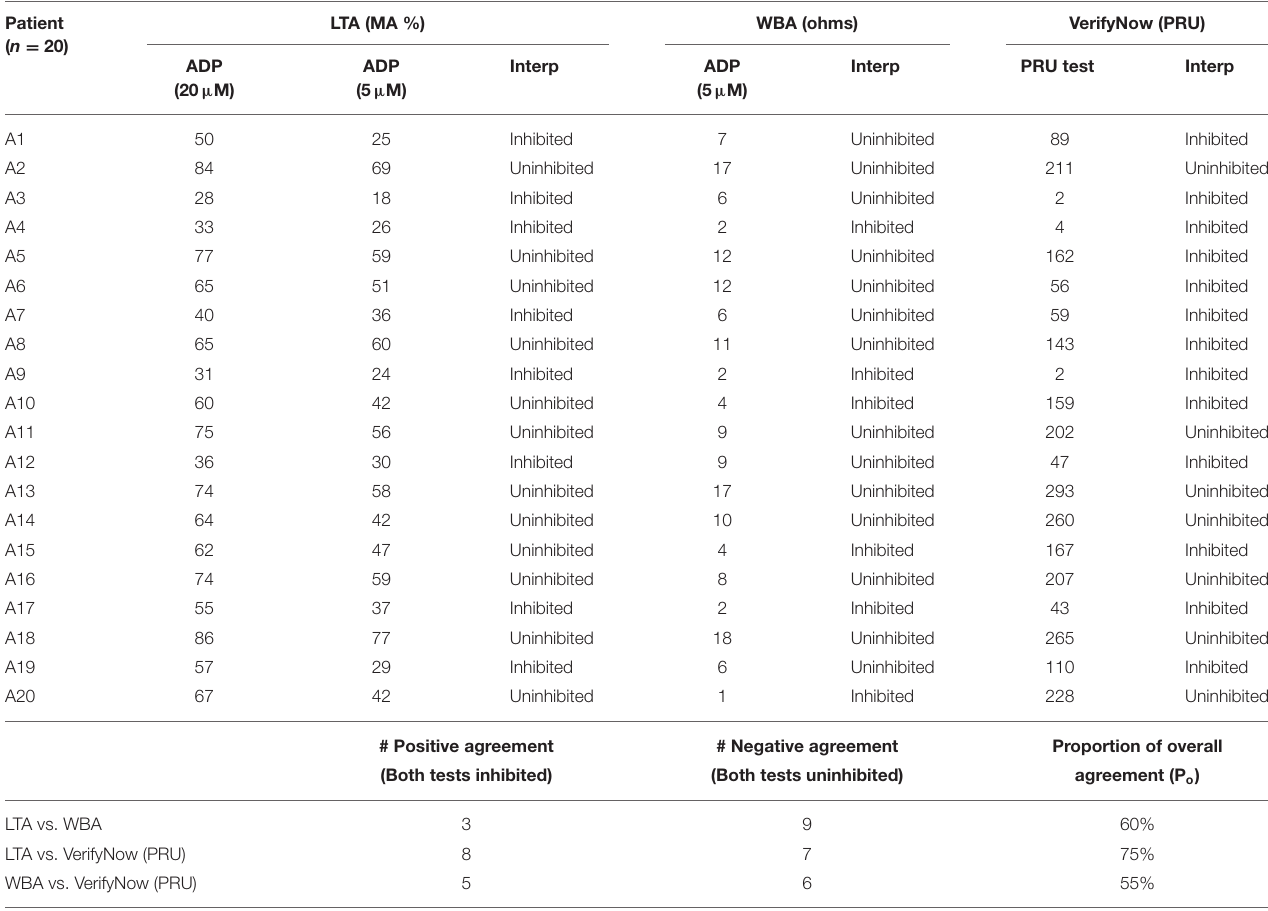
TABLE 1 | Summary of P2Y12-I-response results compared across three testing platforms. Patient ( n =